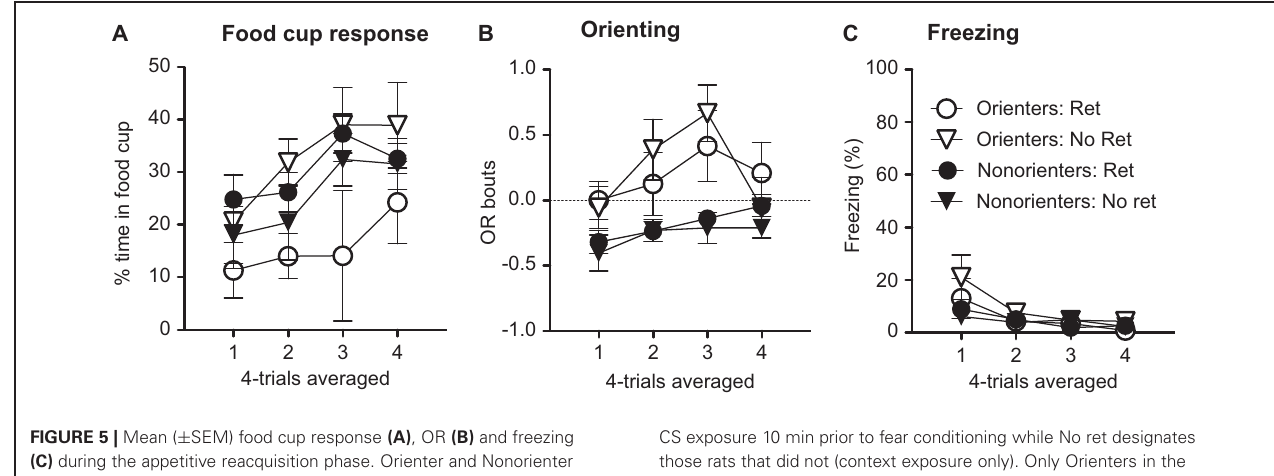
FIGURE 5 | Mean ( ± SEM) food cup response (A) , OR (B) and freezing (C) during the appetitive reacquisition phase. Orienter and Nonorienter designations refer to those rats that developed a robust OR during the original appetitive training (Orienters) and those that did not (Nonorienters). Ret refers to the condition in which rats received a single